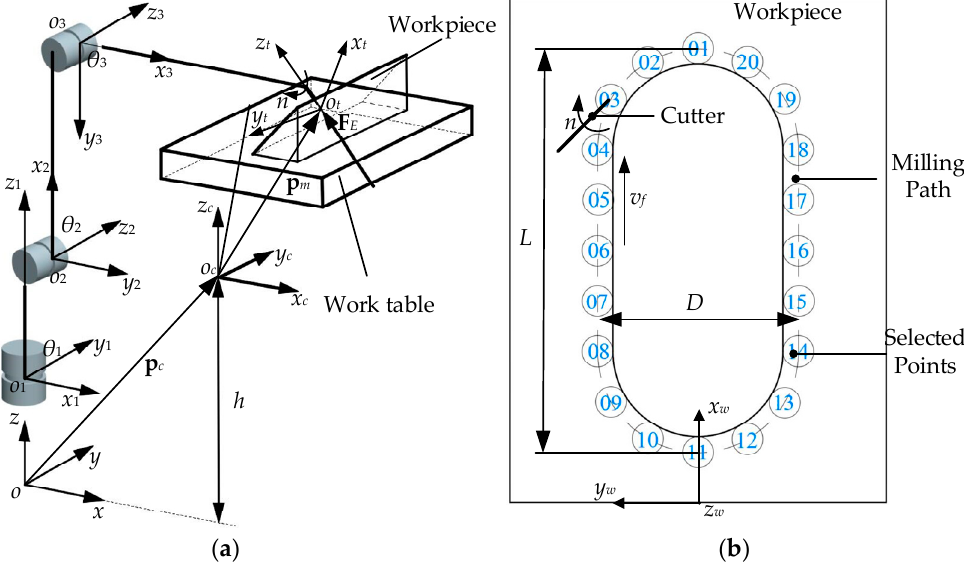
Figure 5. The reference robotic milling system in the simulation: ( a ) The reference coordinate systems of the robot and work table and ( b ) the model of the workpiece and the milling groove.